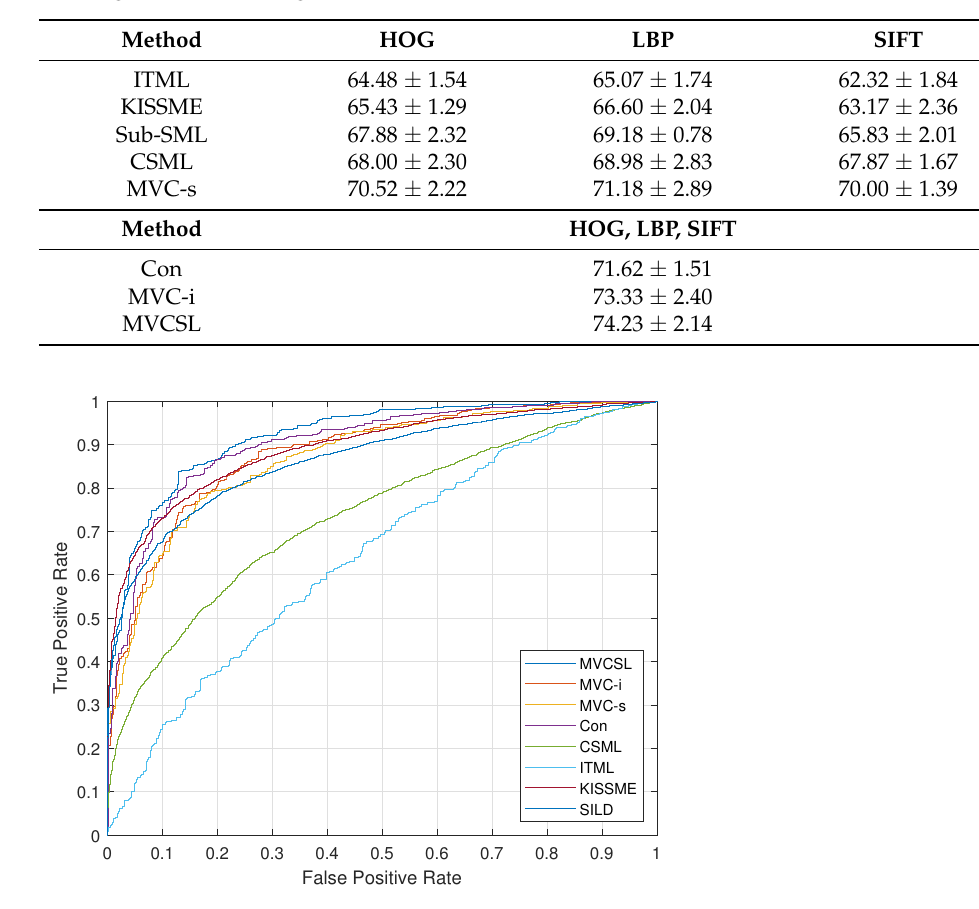
Figure 3. ROC curves of various approaches on the FGFV dataset.